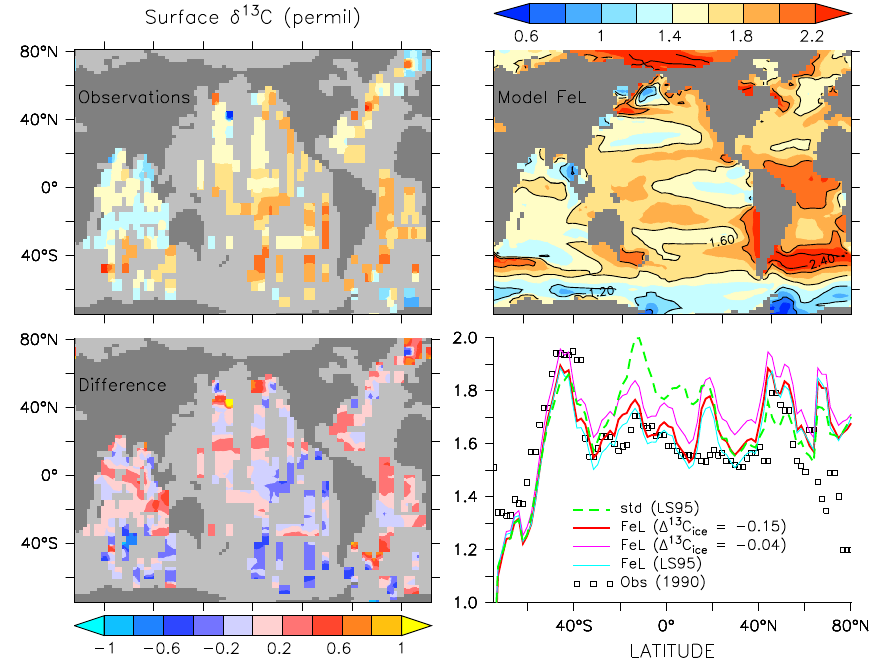
Fig. 9. Comparison of surface δ 13 C DIC distribution from observations of the 1990s (Gruber and Keeling, 2001; top left) and the model (1980– 1999 average, top right). Bottom left: difference model minus observations. Bottom right: zonally averaged values as a function of latitude. Only those model grid boxes are considered in the averaging where corresponding observations exist. Square symbols show observations, the lines show models std (dashed green) and FeL (solid red, purple and light blue lines). The different solid lines explore the uncertainty due to the atmospheric δ 13 C evolution and correspond to the same lines in Fig. 2